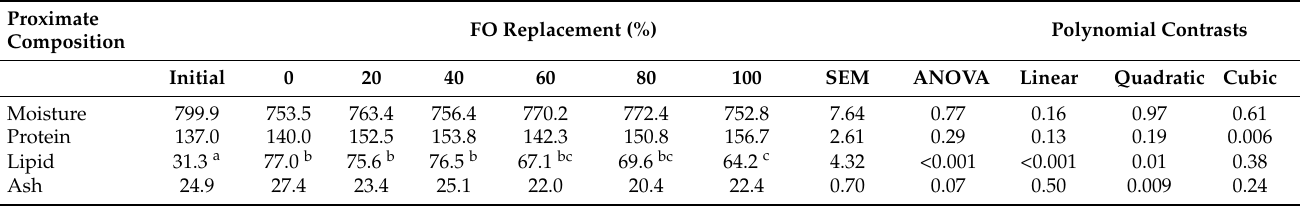
Table 6. Proximate composition (g kg − 1 , wet basis) of the whole-body of juvenile tench fed experi- mental diets with different levels replacement of cod liver oil by a blend of vegetable oils.